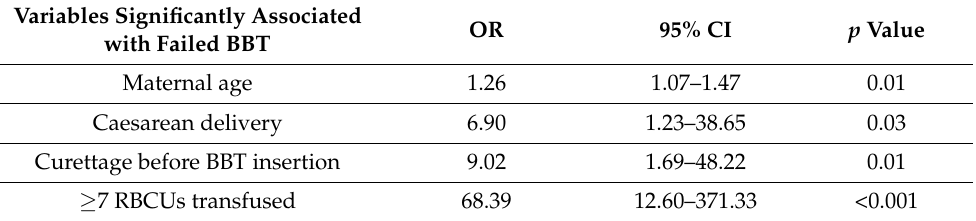
Table 2. Logistic regression analysis of factors for failed Bakri Balloon Tamponade (BBT) manage- ment.